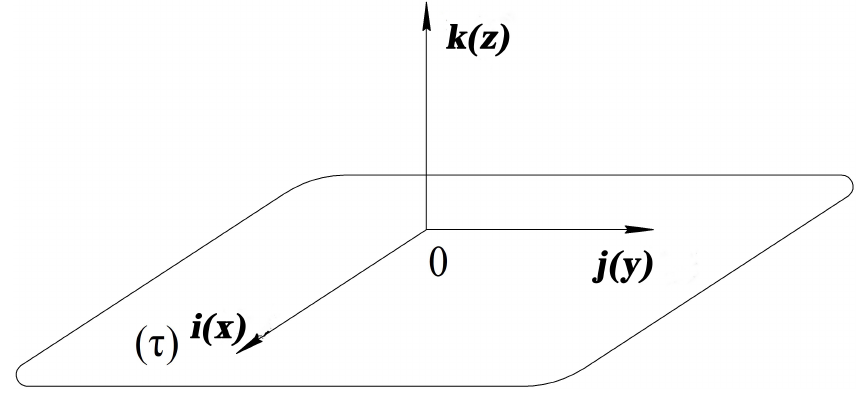
Figure 1. Positional relationship of vectors i , j and k